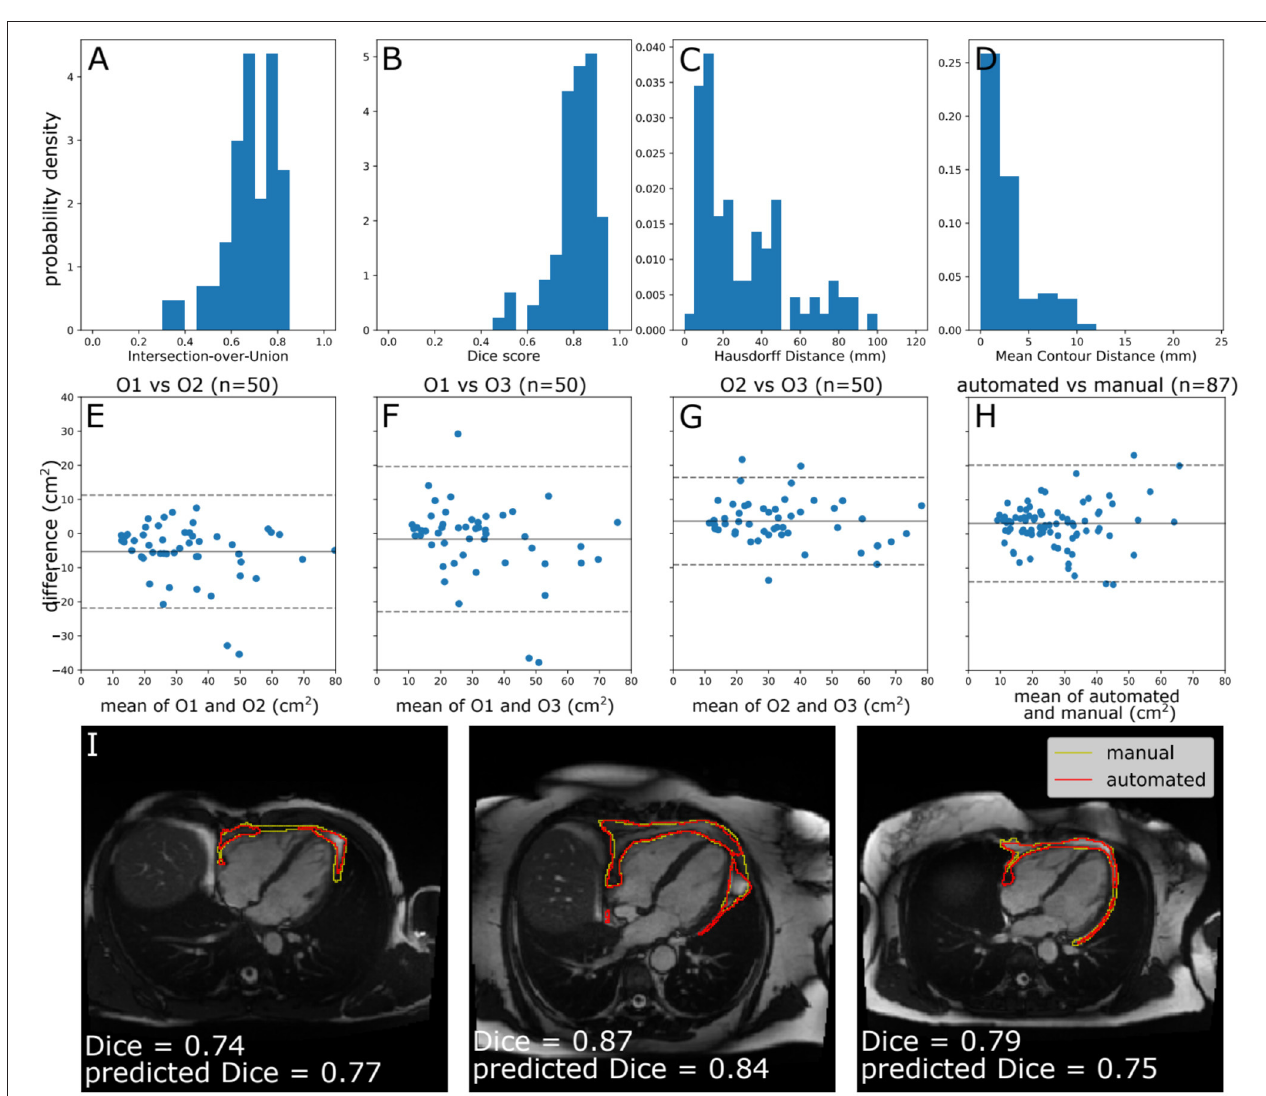
FIGURE 3 | Model performance. (A–D) Histograms of standard segmentation performance metrics on the test set ( n = 87). (E–H) Bland–Altman plots of PAT area between manual measurement between measurements by different human observers, and a human observer (O1) and automated measurement. The x-axis denotes the average of two measurements and the y-axis denotes the difference between them. The dark line is the mean difference, and the dashed lines show ± 1.96 standard deviations from the mean. (E–G) show the inter-observer variability evaluated by three observers (O1–O3) on a randomly selected subset of the manually contoured training set ( n = 50 subjects). (H) shows the agreement between automated and manual measurements in the manually contoured test set ( n = 87 subjects). (I) Example segmentations from the test set, with annotations showing Dice score and the predicted Dice score. Images reproduced with permission of UK Biobank ©